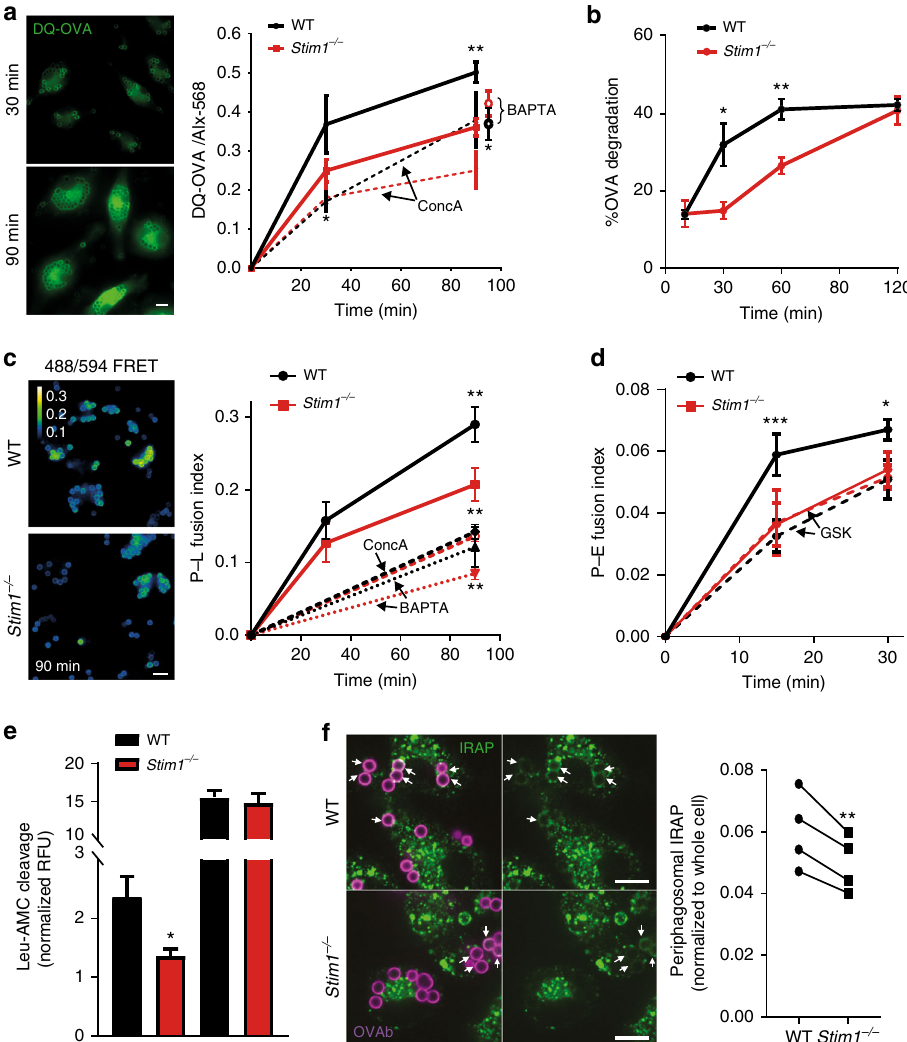
Fig. 7 STIM1 promotes phagosomal proteolysis and endomembrane fusion. a Proteolysis was measured in BMDCs exposed to DQ-OVA-Alexa-568 beads. STIM1-de fi cient cells showed lower levels of DQ-OVA fl uorescence at 90 min (right panel). Pre-incubation with BAPTA-AM (40 μ M) reduced WT proteolysis to levels similar to STIM1-de fi cient cells. Lines representing the BAPTA condition are omitted and 90 min points are displaced to the right for clarity. ConcA (0.2 nM) only partially inhibited proteolysis. N = 5/10/3/5/3 (coverslips) comprising a total of 236/1050/237/432/200 (WT) or 264/975/218/405/217 ( Stim1 − / − ) cells for 30/90/30+ ConcA/90 + ConcA/90 + BAPTA(min). b OVA degradation was measured with anti-OVA immunostainings of isolated phagosomes by fl ow cytometry. Values are % OVA degradation. Full gating strategy is shown in Supplementary Fig. 7a. Proteolysis was decreased at 30 and 60 min after ingestion. N = 3. c Phago – lysosome (P – L) fusion was measured by exposing Alexa-488-OVAb to cells loaded with lysosomal FRET acceptor Alexa-594-HA. Colour-coded images (left) show the FRET signal at 90 min for WT and STIM1-de fi cient cells. P – L fusion indices are matched to the colour-coded bar. P – L fusion was decreased in STIM1-de fi cient cells as compared to WT at 90 min, whereas BAPTA-AM loading further decreased P – L fusion and eliminated differences between WT and Stim1 − / − cells. ConcA decreased P – L fusion to similar levels as BAPTA- loaded cells. N = 3/4/4/3 (coverslips) comprising 470/1009/1691/797 (WT) or 643/1314/1617/503 ( Stim1 − / − ) phagosomes for 30/90/90 + ConcA/ 90 + BAPTA (min). d Phago – endosome (P – E) fusion was measured by exposing Alexa-488-OVAb to cells loaded with endosomal FRET acceptor Alexa- 594-dextran. P – E fusion was decreased in STIM1-de fi cient cells as compared to WT. Addition of GSK (10 μ M) eliminated differences in P – E fusion. N = 3 (coverslips) comprising a total of 213/244/144/146 (WT) or 210/154/233/253 ( Stim1 − / − ) cells for 15/30/15+ GSK/30 + GSK(min). Phagocytic targets added at 20:1. e Leu-AMC fl uorescent substrate cleavage was reduced in phagosomes isolated from STIM1-de fi cient cells but not in whole-cell lysates, N = 3. f Periphagosomal IRAP, quanti fi ed from single confocal slices, was reduced in STIM1-de fi cient cells. N = 4 (coverslips). White bars = 10 μ m. Error bars are means ± SEM. * p < 0.5, ** p < 0.01 using a two-way ANOVA and Sidak ’ s post test for a – d and a Student ’ s t -test for e and f Pre-loading cells with BAPTA-AM reduced proteolysis in both leaked from the phagosome into the cytosol, indicating that genotypes to the levels of untreated Stim1 − / − cells, indicating that proteolysis occurred (Fig. 7a). Contrary to macrophages 27 , pha- gosomal proteolysis reported by this assay was only partially STIM1 mediates Ca 2+ -dependent proteolysis in BMDCs inhibited by ConcA (Fig. 7a). Stim1 ablation signi fi cantly (Fig. 7a). As an alternative approach, the levels of phagosome- decreased DQ-OVA fl uorescence by ∼ 30% at 90 min. This effect associated OVA was determined by quantifying anti-OVA tended to persist in the presence of ConcA, although the differ- immunostaining of isolated BMDC phagosomes 28 . OVA degra- ence here was not signi fi cant ( p = 0.09) (Fig. 7a). dation was inhibited in STIM1-de fi cient cells at 30 and 60 min NATURE COMMUNICATIONS | 8: